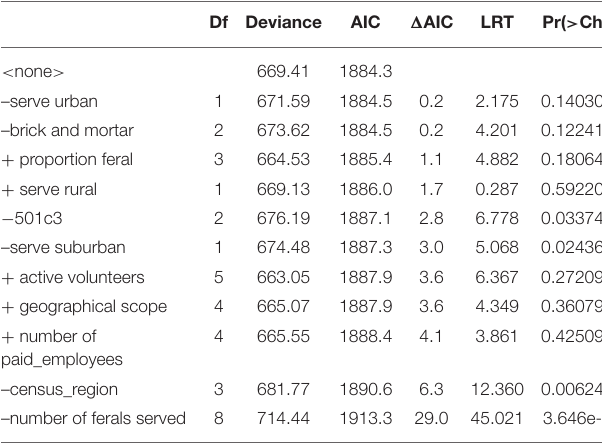
TABLE 2 | A comparison of model terms and their test statistics.